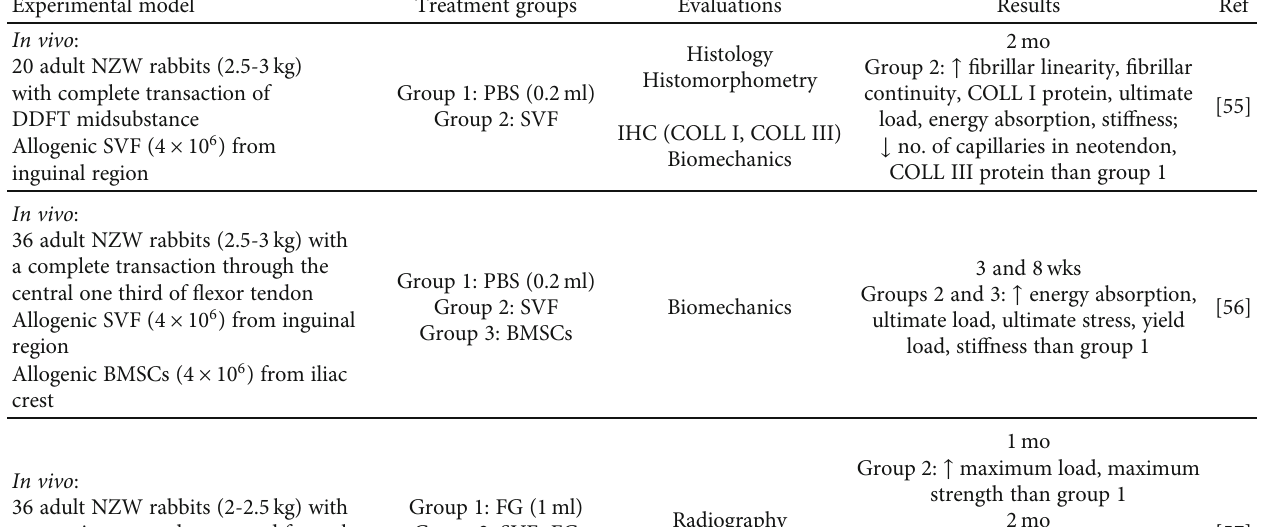
Table 3: In vitro , in vivo , and clinical studies on SVF in tendon regeneration. Experimental